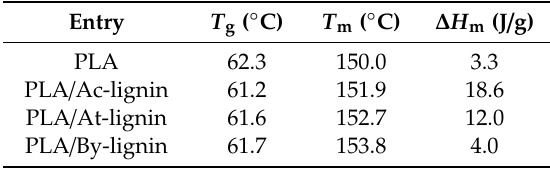
Figure 13. DSC thermograms of acidified, acetoacetate, and butyric lignin. Table 2. The DSC data of PLA/lignin biocomposites.